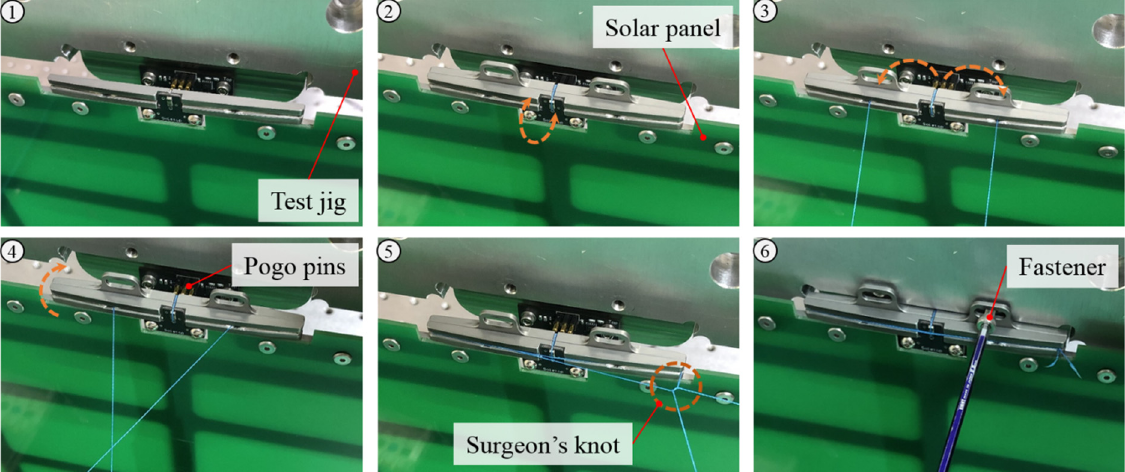
Figure 8. Solar panel’s wire-tightening process.